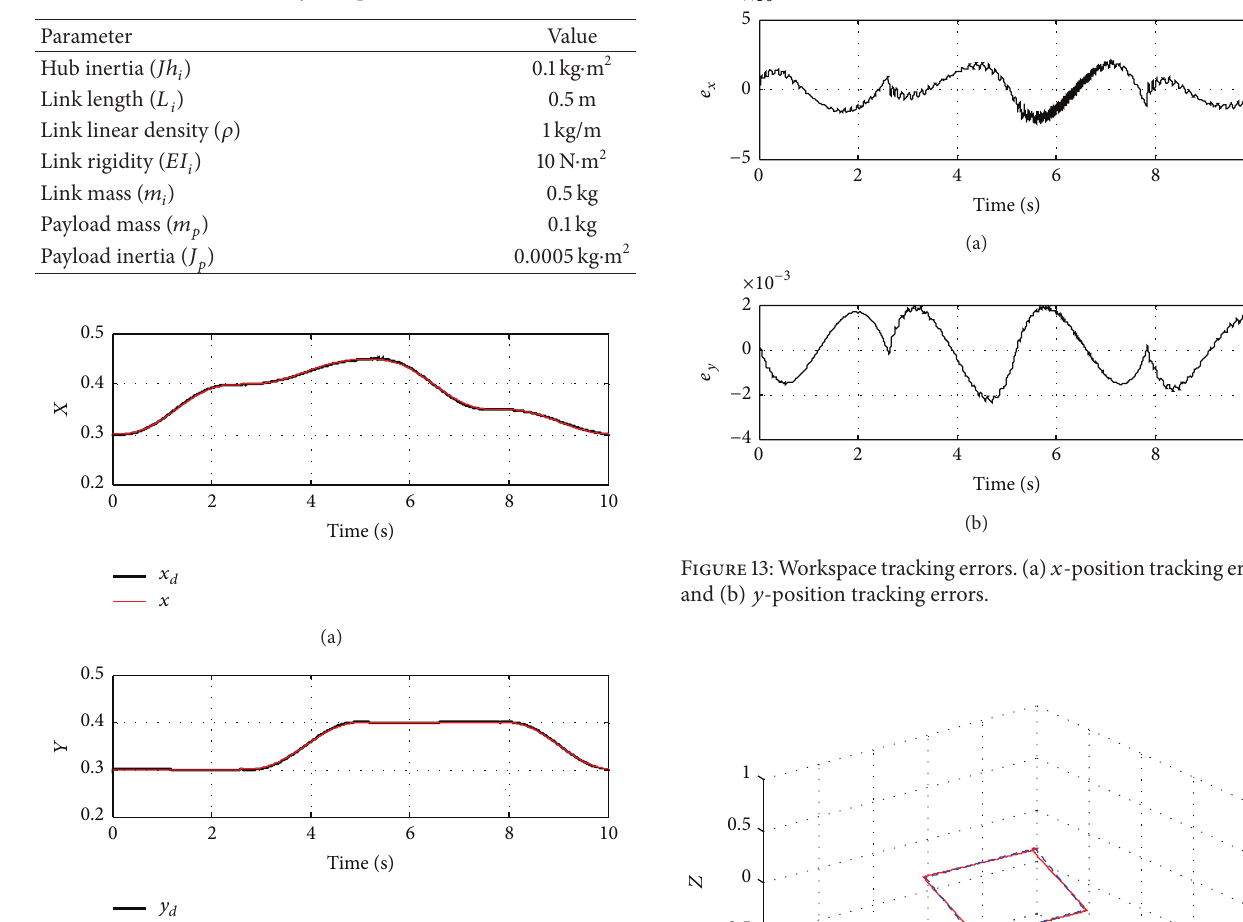
Table 1: System parameters.